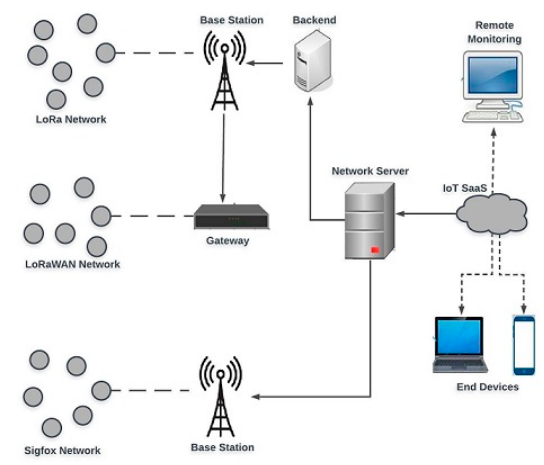
Figure 6. Internet of Things (IoT) mixed architecture.